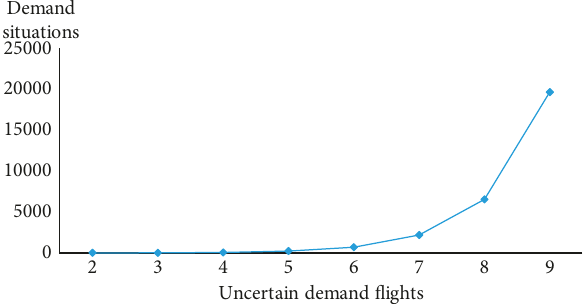
Figure 4: Exponential growth of demand situations for a stage.